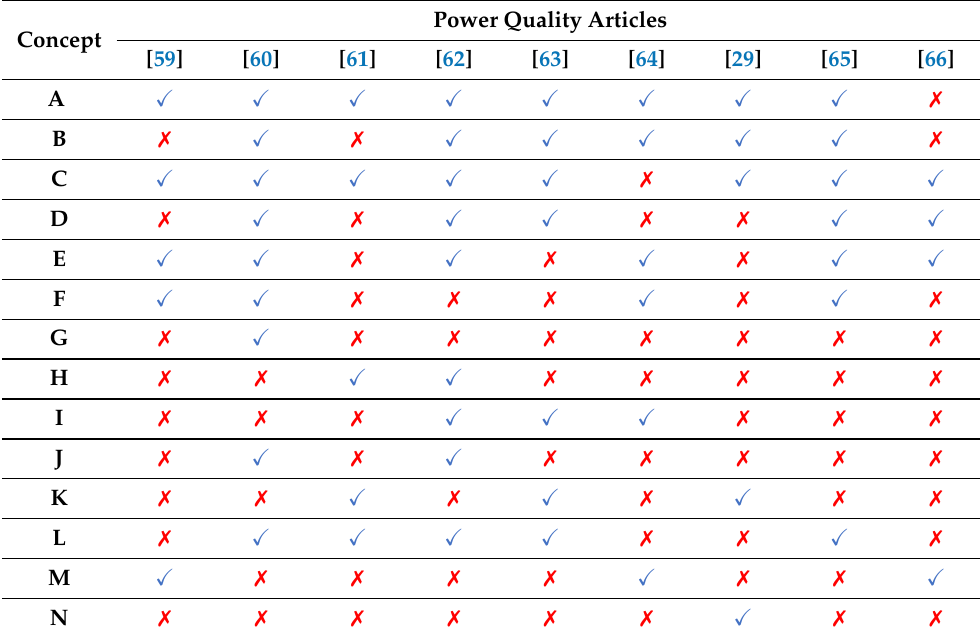
Table 2. Summary of the recently published secondary control for power Communication Robustness.